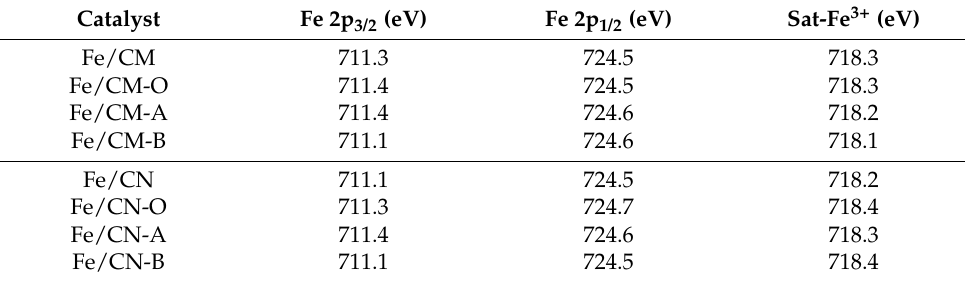
Table 4. Binding energy of Fe2p peaks in the XPS spectrum.